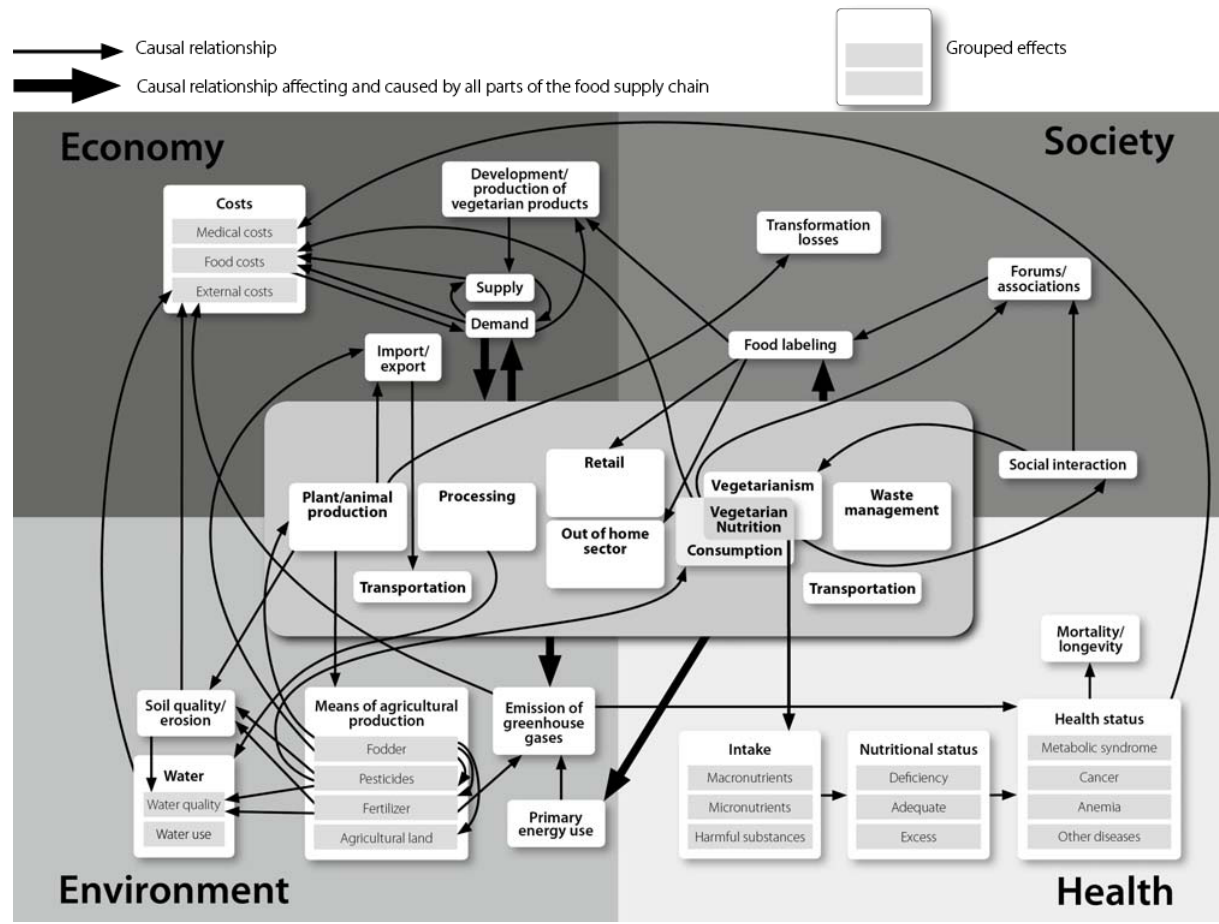
Figure 2. Qualitative model of the effects of vegetarian